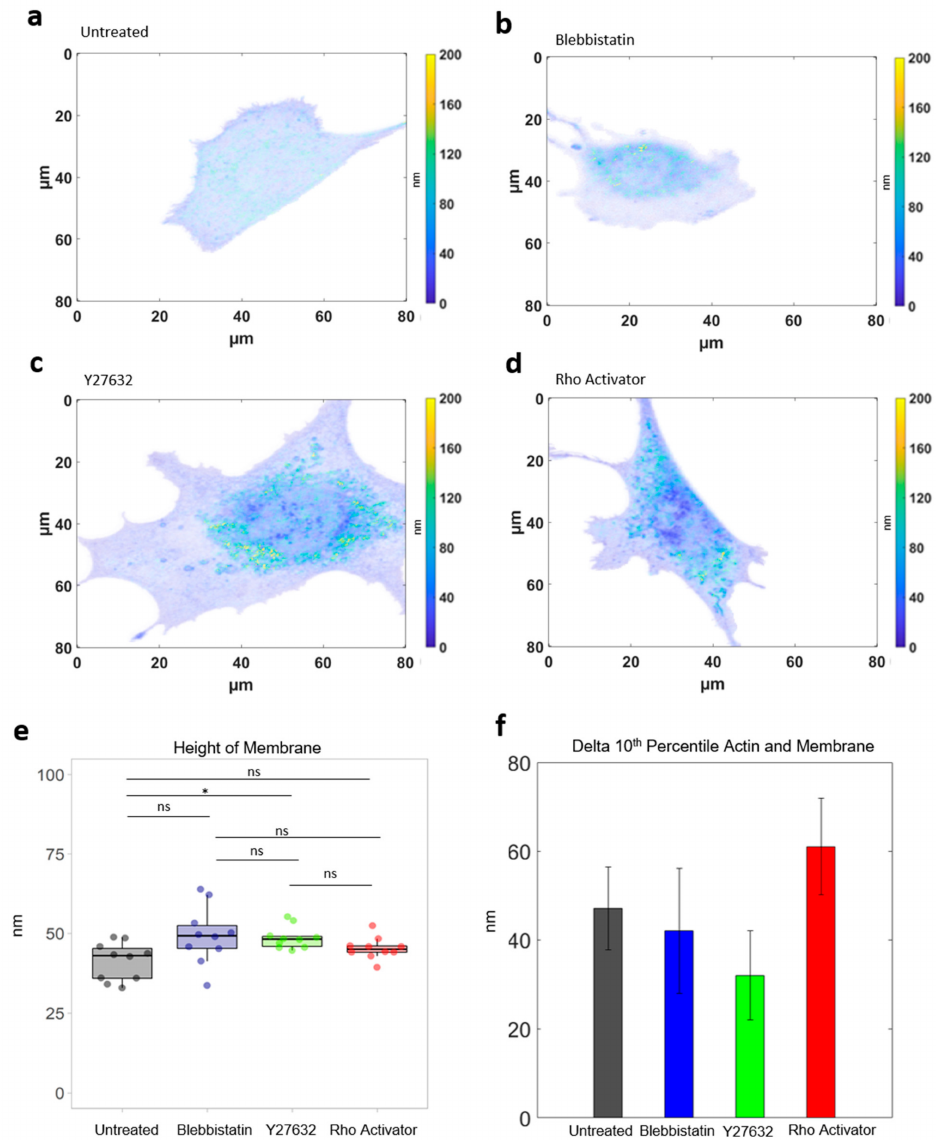
Figure 6. Cell membrane analysis. Intensity weighted height image of the cell membrane ( a ) Un- treated cell. ( b ) Blebbistatin-treated cells. ( c ) Y27632-treated cells. ( d ) Rho-activator-treated